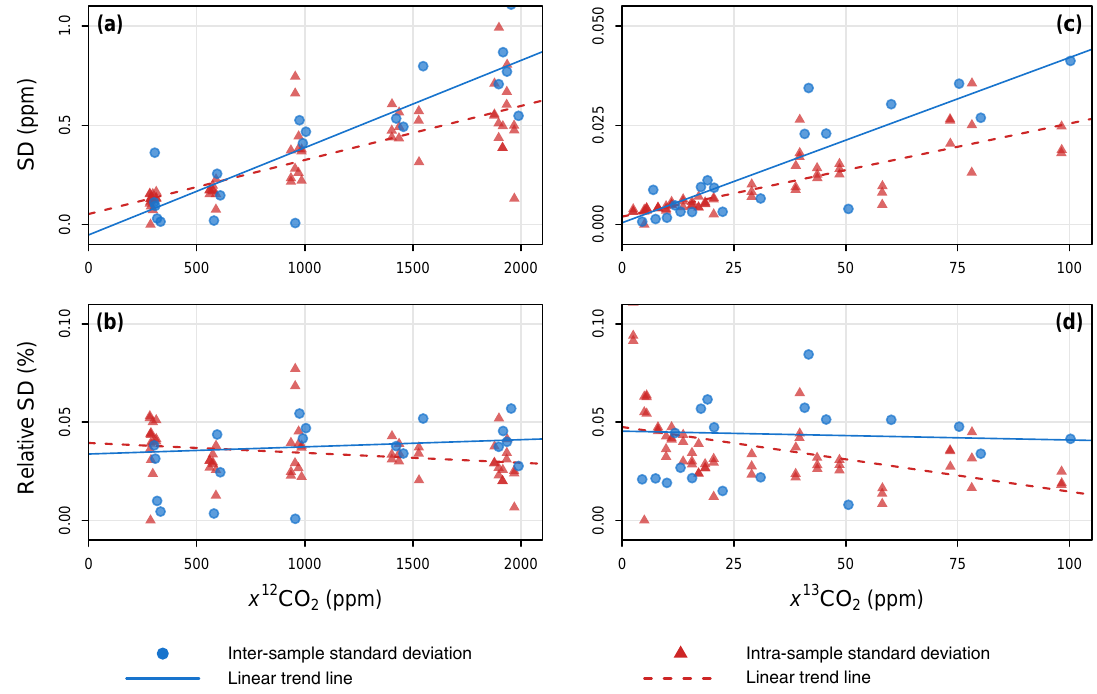
Figure 5. Precision in syringe sample data for x 12 CO 2 (a, b) and x 13 CO 2 (c, d) as quantified by standard deviations (a, c) and relative standard deviations (b, d) for individual measurements (red) and replicate measurements